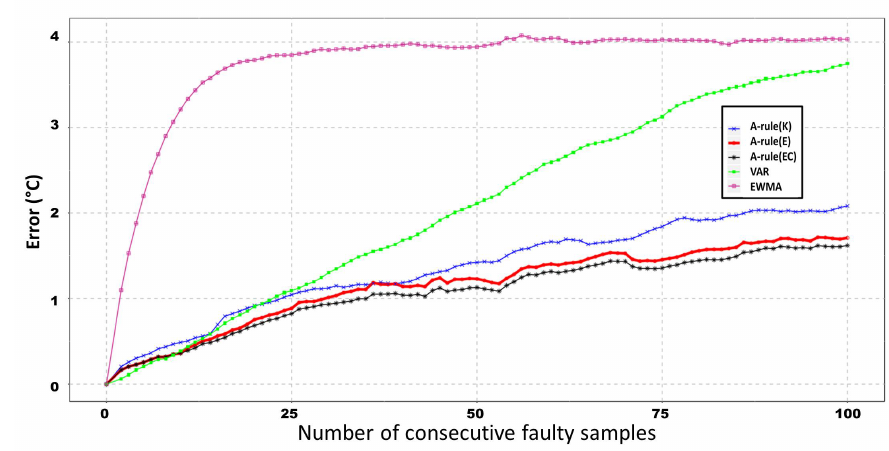
Figure 11. The average of the difference between the real observations and corrected values for 100 data sets for cleaning temperature